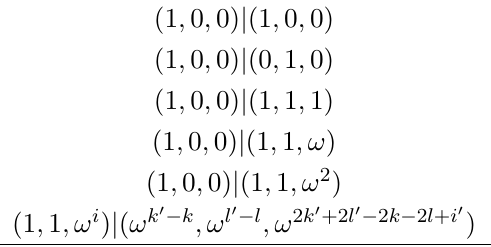
Table 5 . List of VEV directions for the potential of two triplets of (cid:1)(54), V